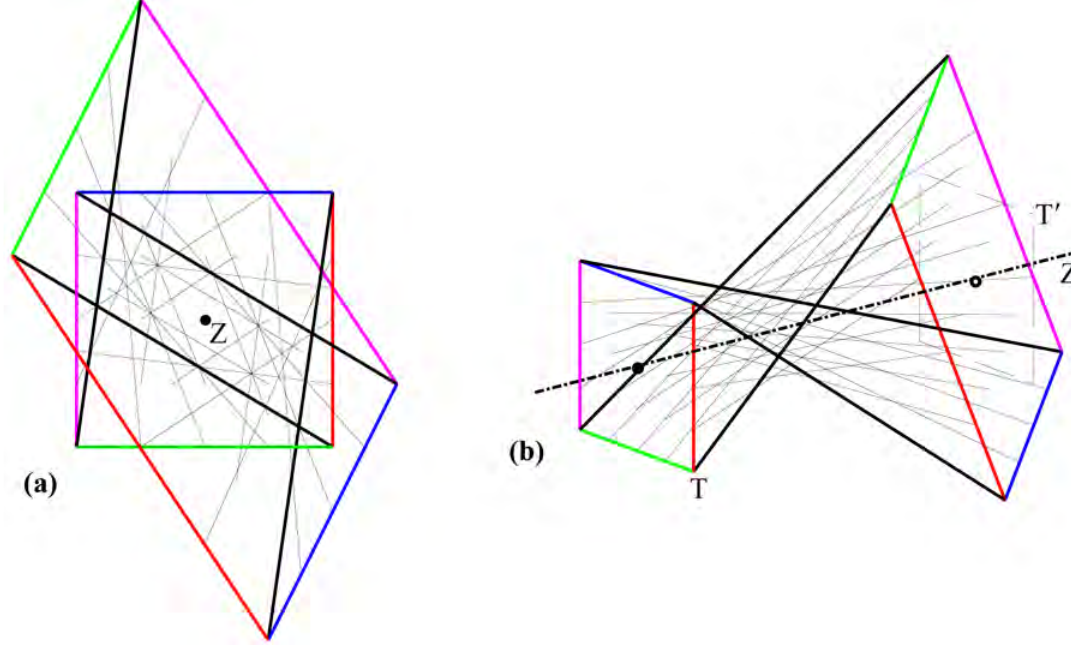
Figure 12 A pencil with divergency 2/4/ LJIM ++−= D at T. There are no principal meridional planes or foci. The addi- tional antisymmetric component has obliterated the single line focus of Figure 11. (b) azimuth °− 20 40 °− 20 , elevation 18 °− 20